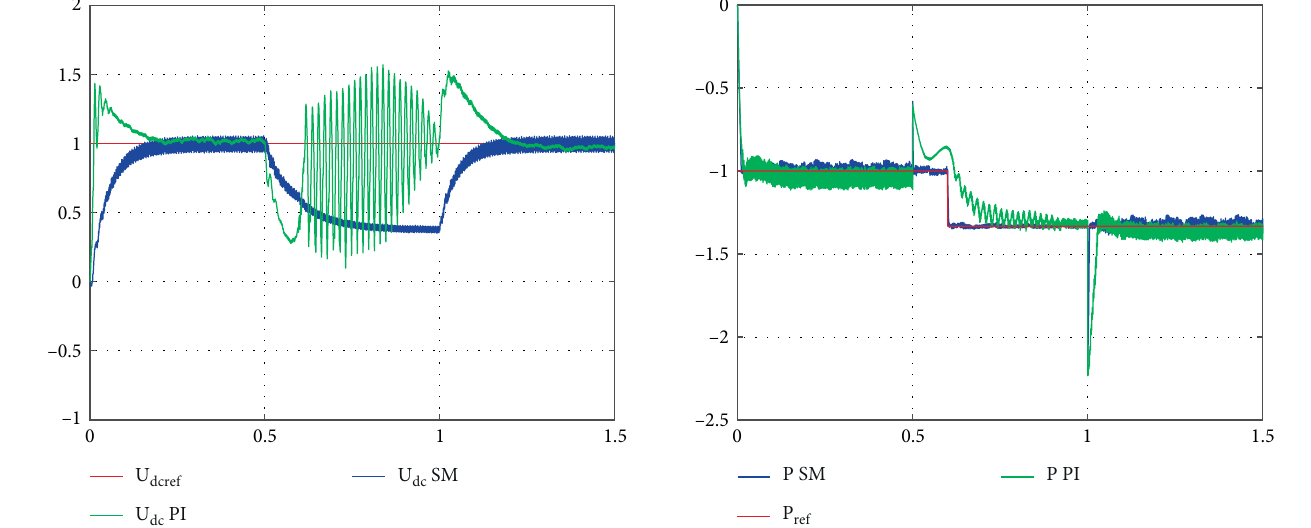
Figure 15: DC BUS voltage with 40% depth of stator voltage.